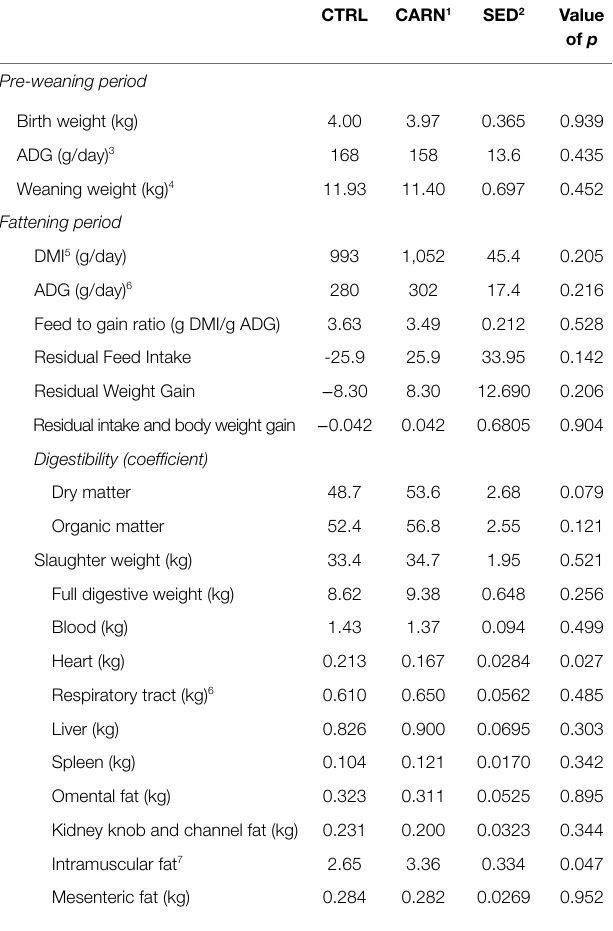
TABLE 4 | Pre and post-weaning growth performance, feed efficiency, digestibility, and visceral organ weights (kg) and fat depots (kg) of early feed restricted lambs being fed the control (CTRL) or the L-Carnitine diet (CARN) during the fattening